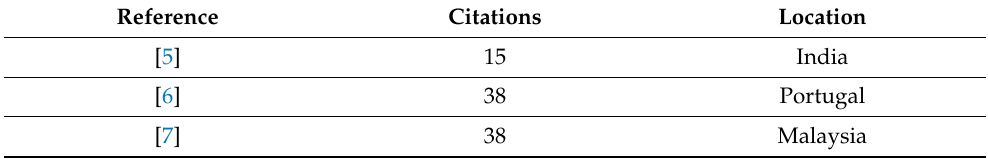
Table A1. Number of citations and location of selected review articles with at least 5